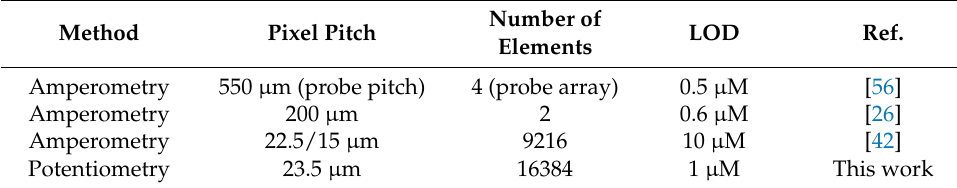
Figure 12. Time-dependent change of output image for addition of 1 µ M Glu. Labels below images indicate elapsed times after addition of Glu. Table 1. Comparison of performance of sensor arrays for Glu